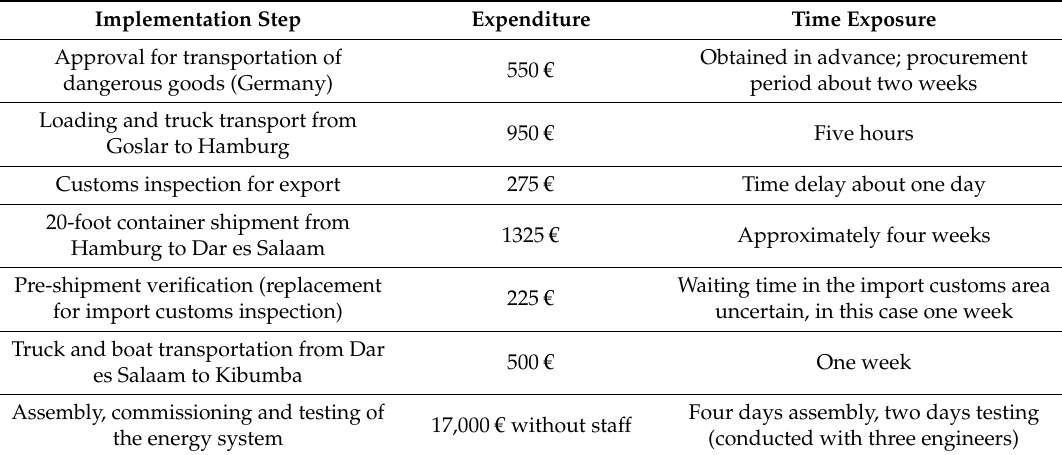
Table 2. Listing of the system implementation expenses in terms of work or organization packages, costs and